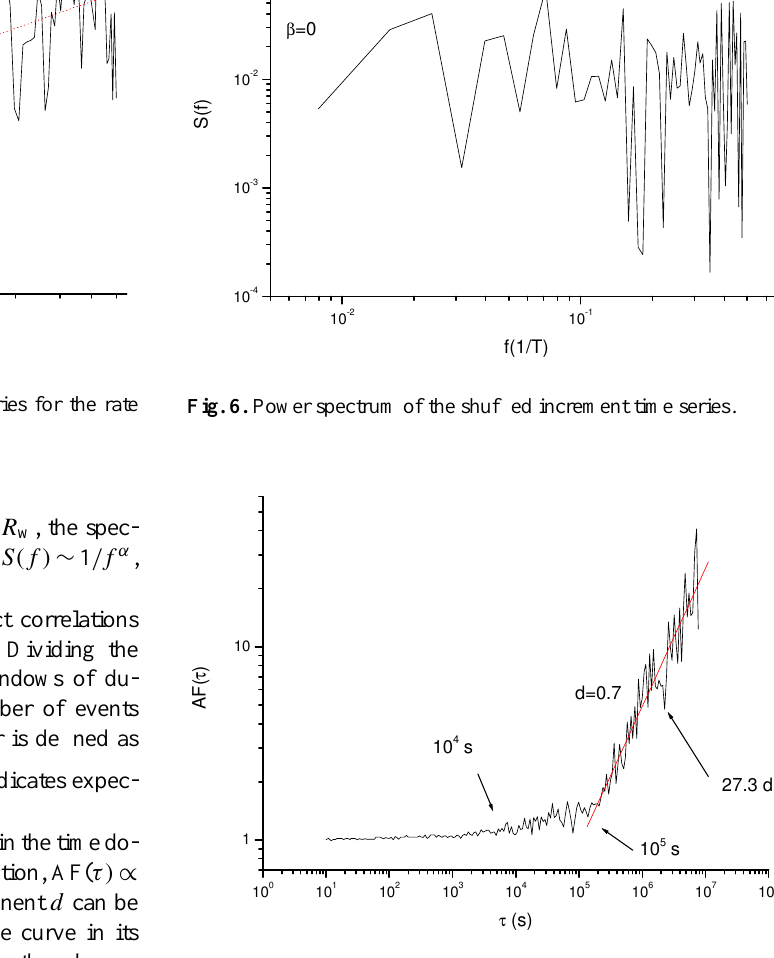
Fig. 7. Allan Factor of the seismic series of cluster